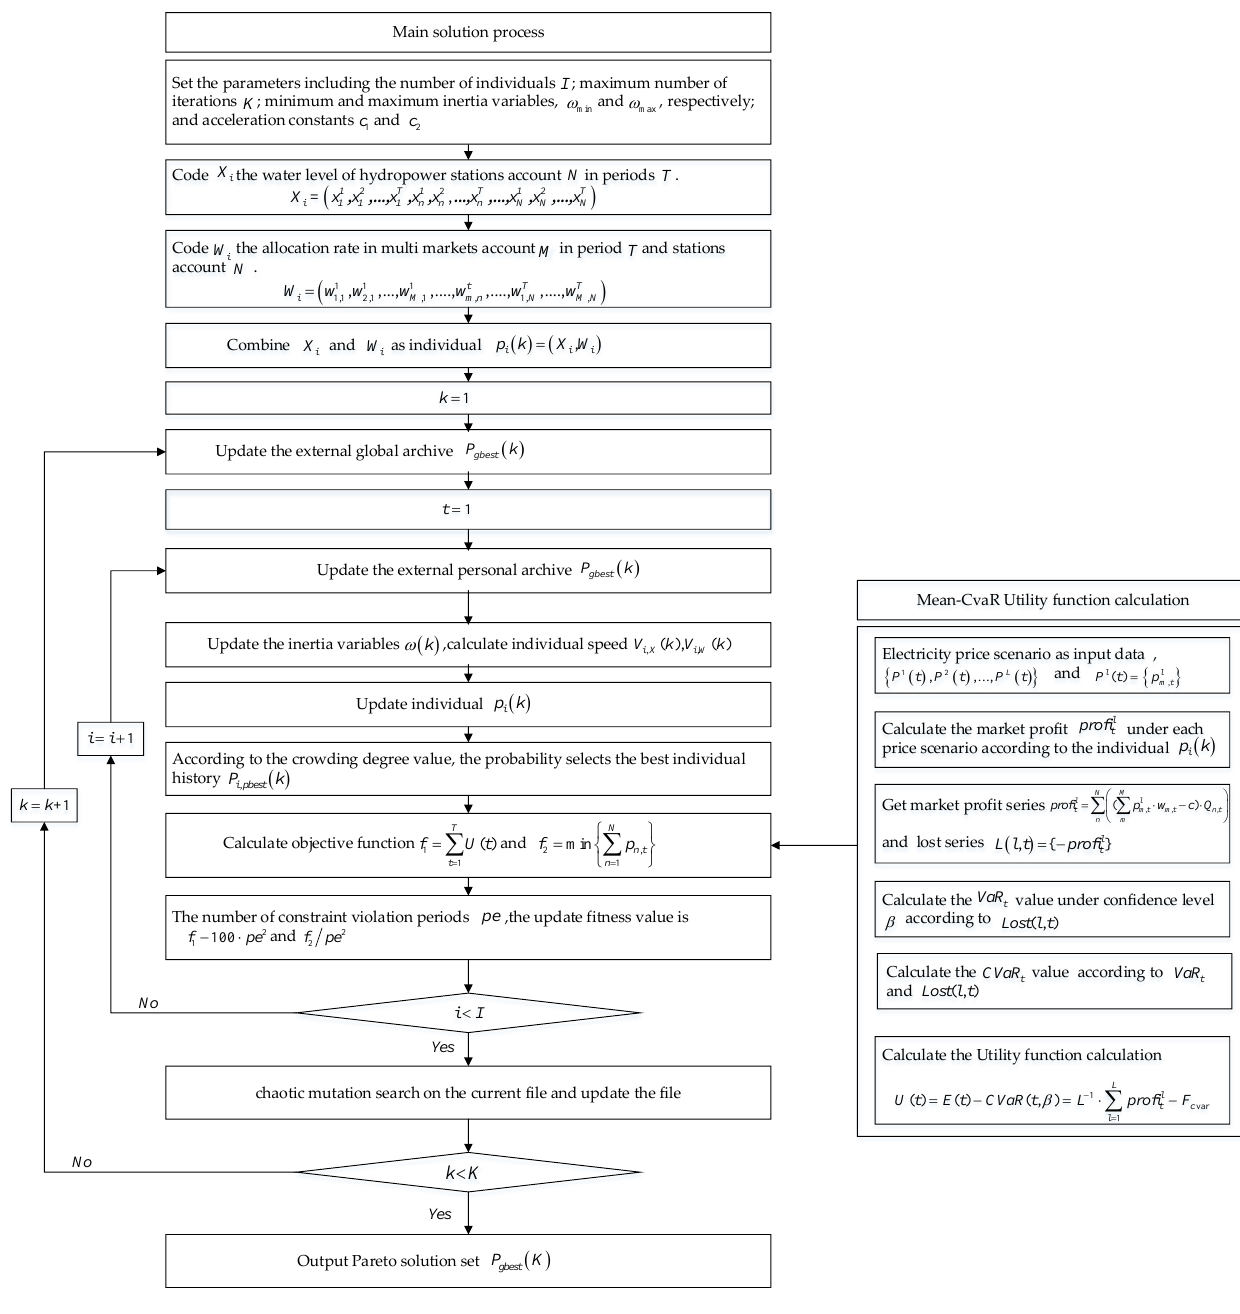
Figure 2. Multi-objective Particle Swarm Optimization Solution